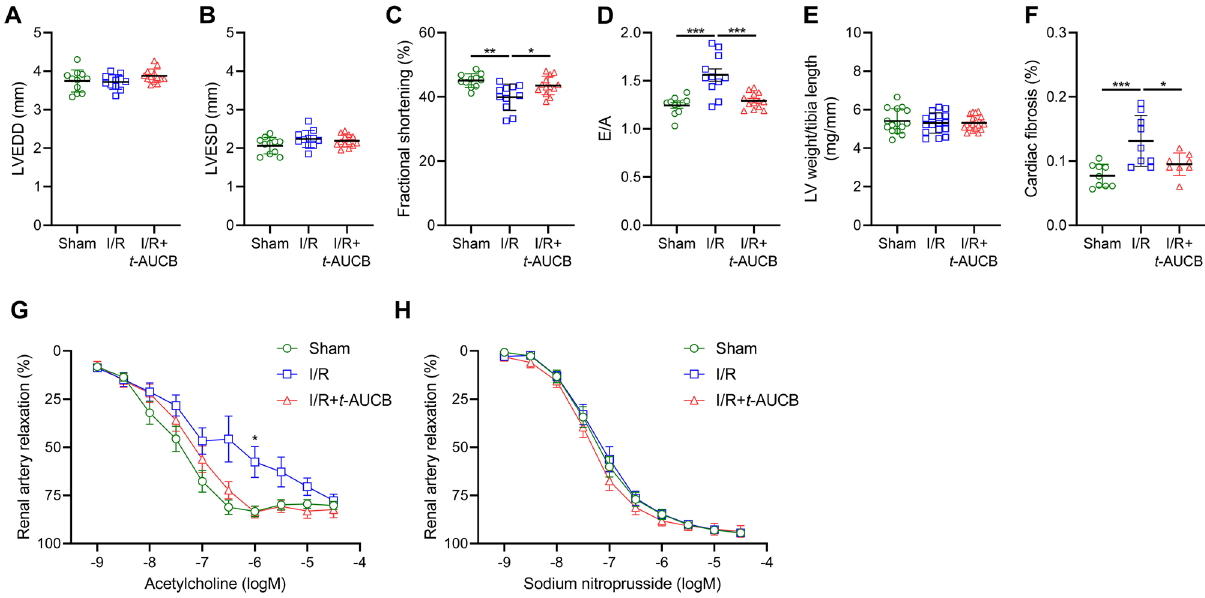
Figure 7. Impact of soluble epoxide hydrolase inhibition on cardiovascular alterations induced by renal- ischemia reperfusion injury Left ventricular end-diastolic (LVEDD; A ) and end-systolic (LVESD; B ) diameters, fractional shortening ( C ), E/A ratio ( D ), LV weight ( E ), cardiac fibrosis ( F ), endothelium-dependent relaxations to acetylcholine ( G ) and endothelium-independent relaxations to sodium nitroprusside ( H ) determined 28 days after surgery in sham-operated mice and mice subjected to bilateral renal ischemia/reperfusion (I/R) treated or not with the soluble epoxide hydrolase inhibitor t -AUCB. * P <